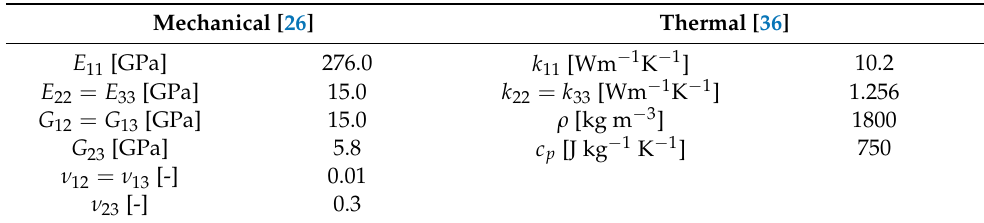
Table 1. Carbon fiber mechanical and thermal